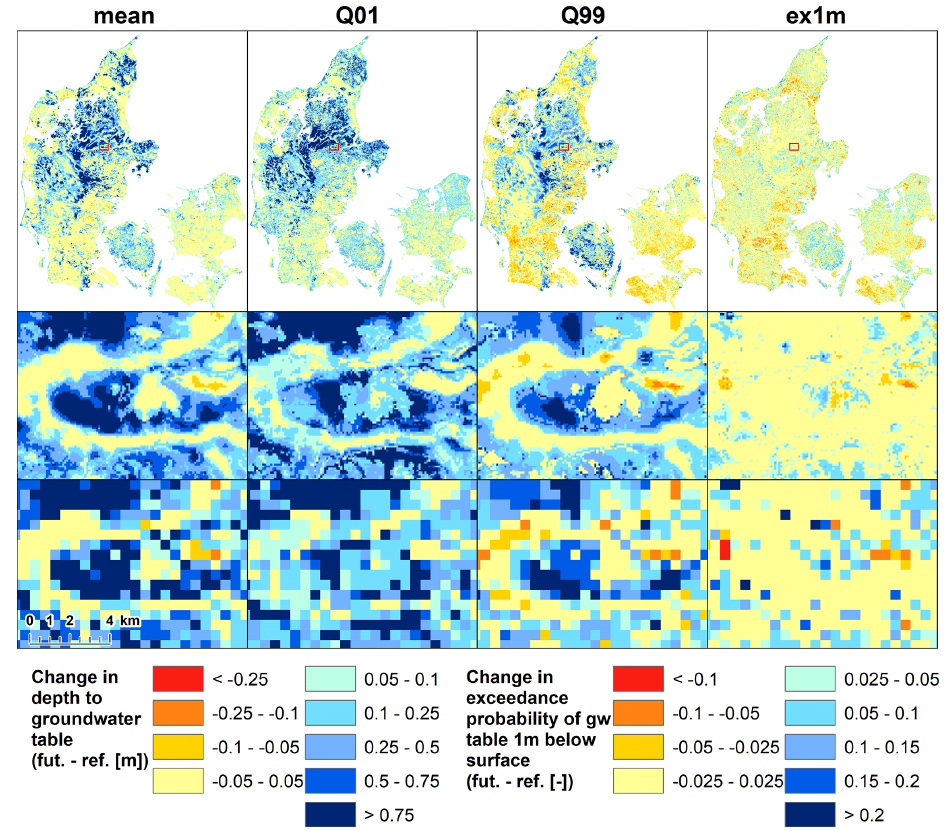
Figure 9. Results of the downscaling, for the far future of all four TBDVs. Top row: Downscaling results in 100m for all of Denmark. Middle row: Detail of the 100m downscaling results (extent indicated in top row). Bottom row: Same detail for the corresponding TBDV in